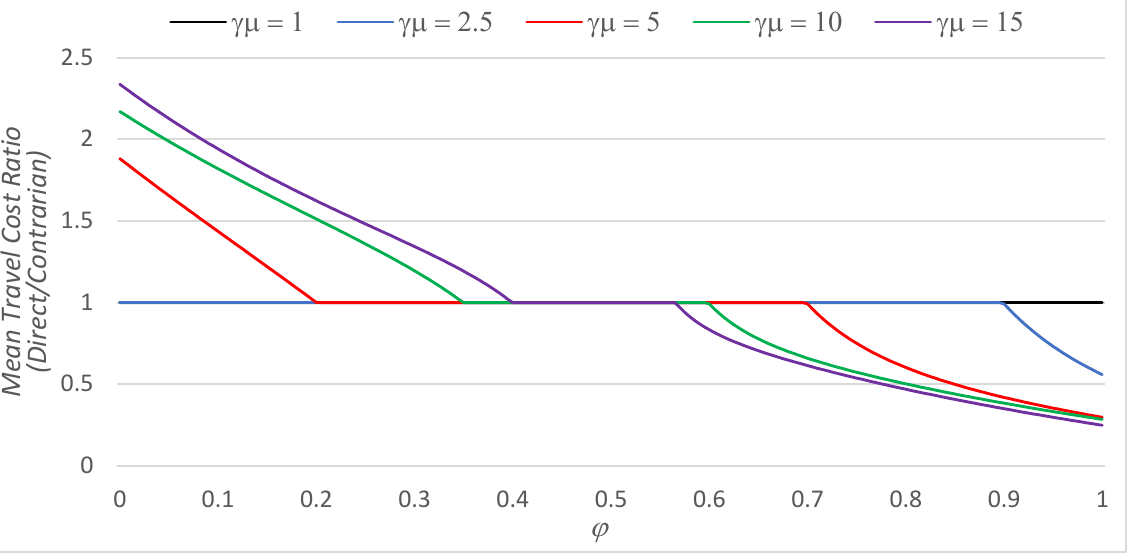
Figure 8. Long-term ratio of direct to contrarian mean travel cost as a function of 𝜑 for 𝛼 = 0.9, 𝛽 = 0.9 and different values of 𝛾𝜇 (case of linear link cost functions).